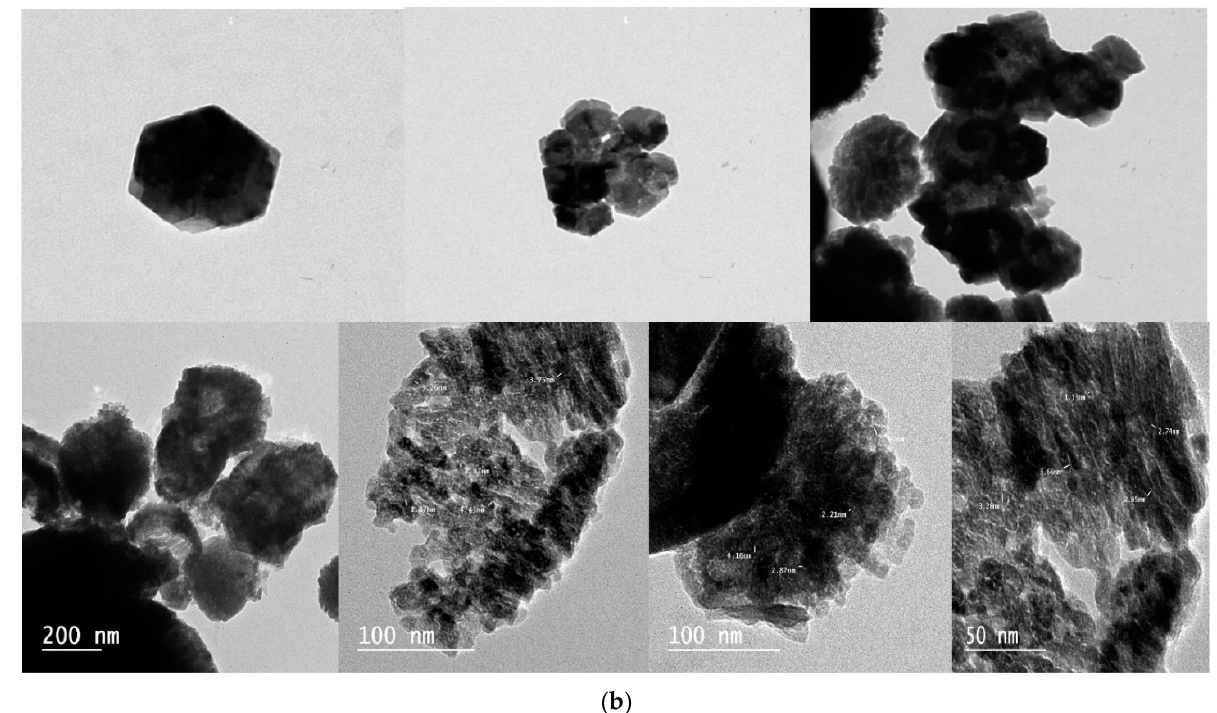
Figure 6. ( a ) SEM analysis of synthesized Er-ZnONPs; ( b ) TEM analysis of synthesized Er-ZnONPs.